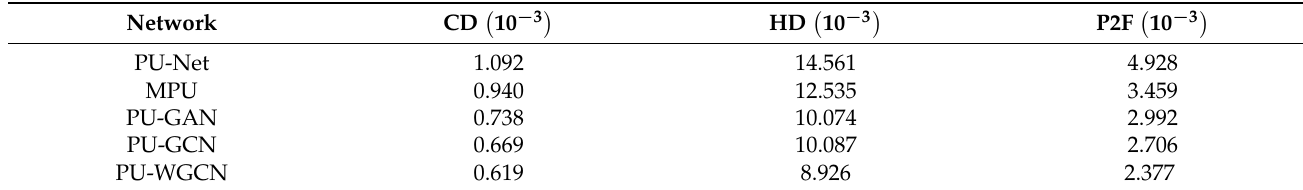
Table 4. Comparison of upsampling results for point cloud numbers from 2048 to 8192.